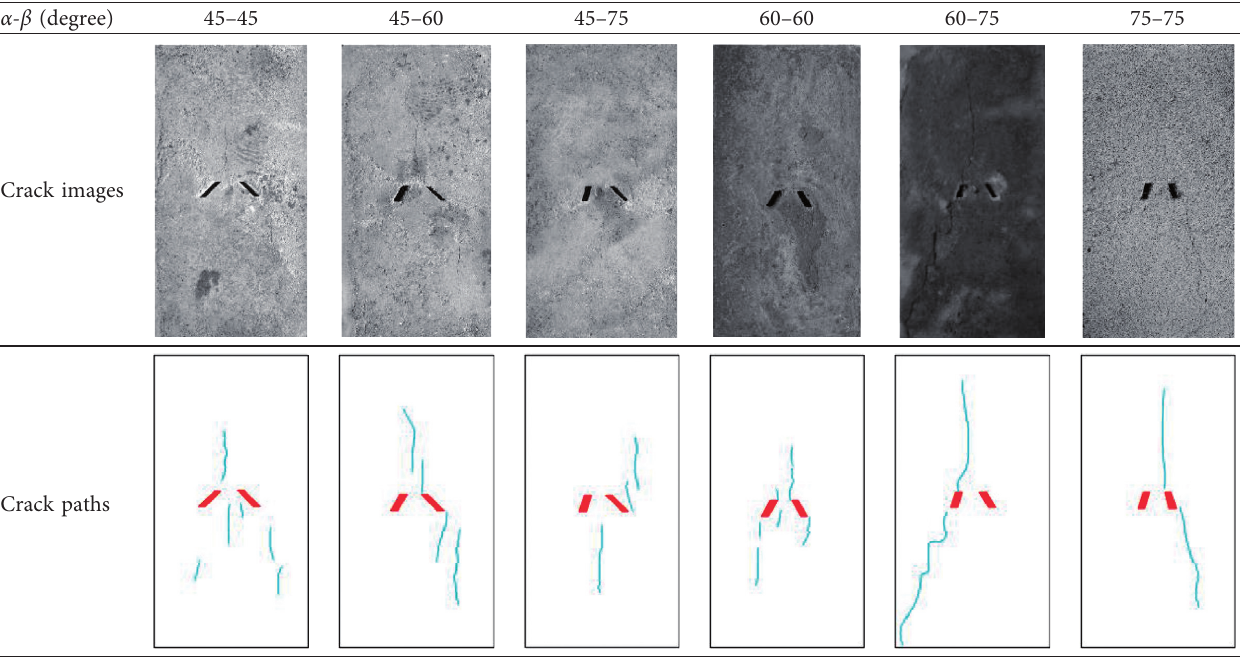
Table 3: Macro crack coalescence process in the specimens containing two parallelogram flaws with different angles under uniaxial